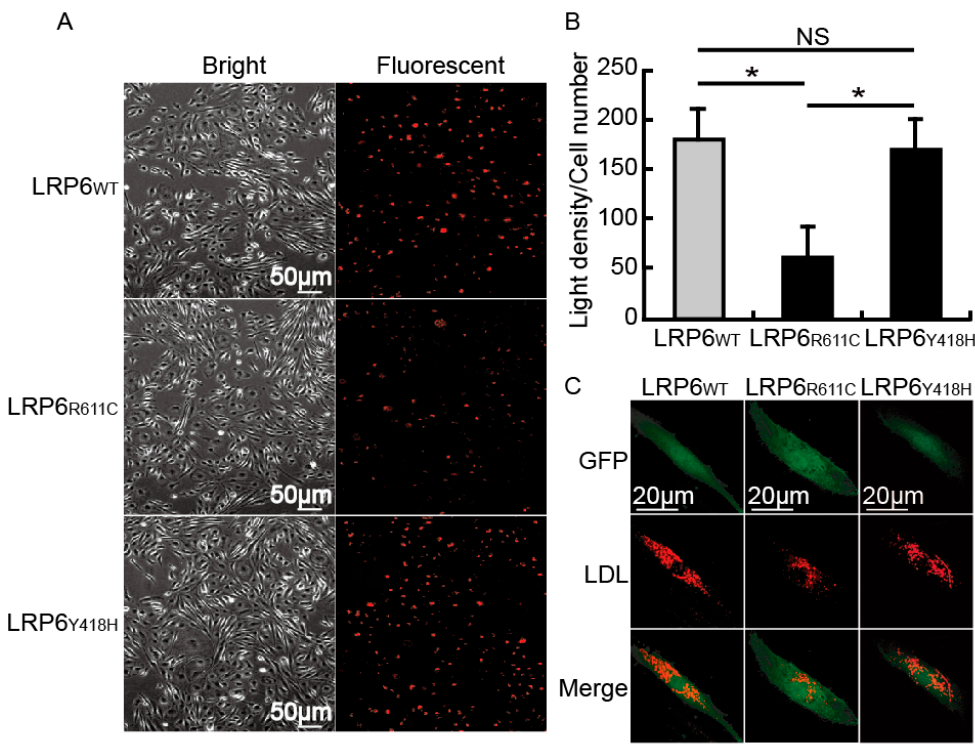
Figure 4. Effect of LRP6 Y418H and LRP6 R611C on LDL uptake in HUVEC. ( A ) An overview of the Dil-LDL uptake in HUVEC; Left, bright field; Right, Fluorescent field; ( B ) Quantitative results were calculated using six random views from three independent replications. Error bars, standard deviation. * indicate p -value for one-way ANOVA plus post-hoc test <0.05. NS, not significant; ( C ) Enlarged views for single cells. Top, GFP translated by IRES following LRP6 ; Middle, Dil-LDL; Bottom, merged data.